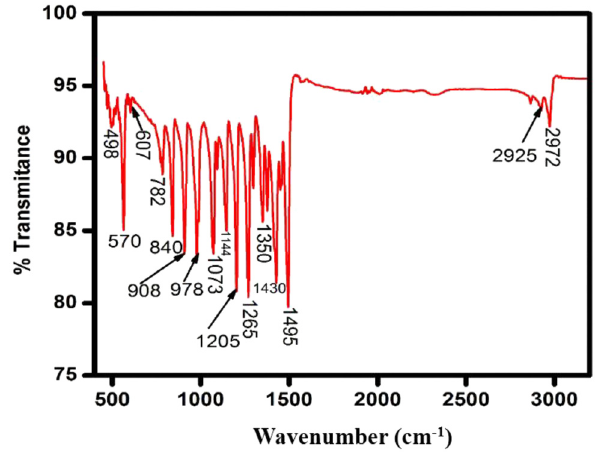
Figure A1: FTIR spectrum of complex 1 synthesized by the metathetical reaction of thallium nitrate trihydrate with sodium diethyl dithiocarbamate ligand in methanol solvent.